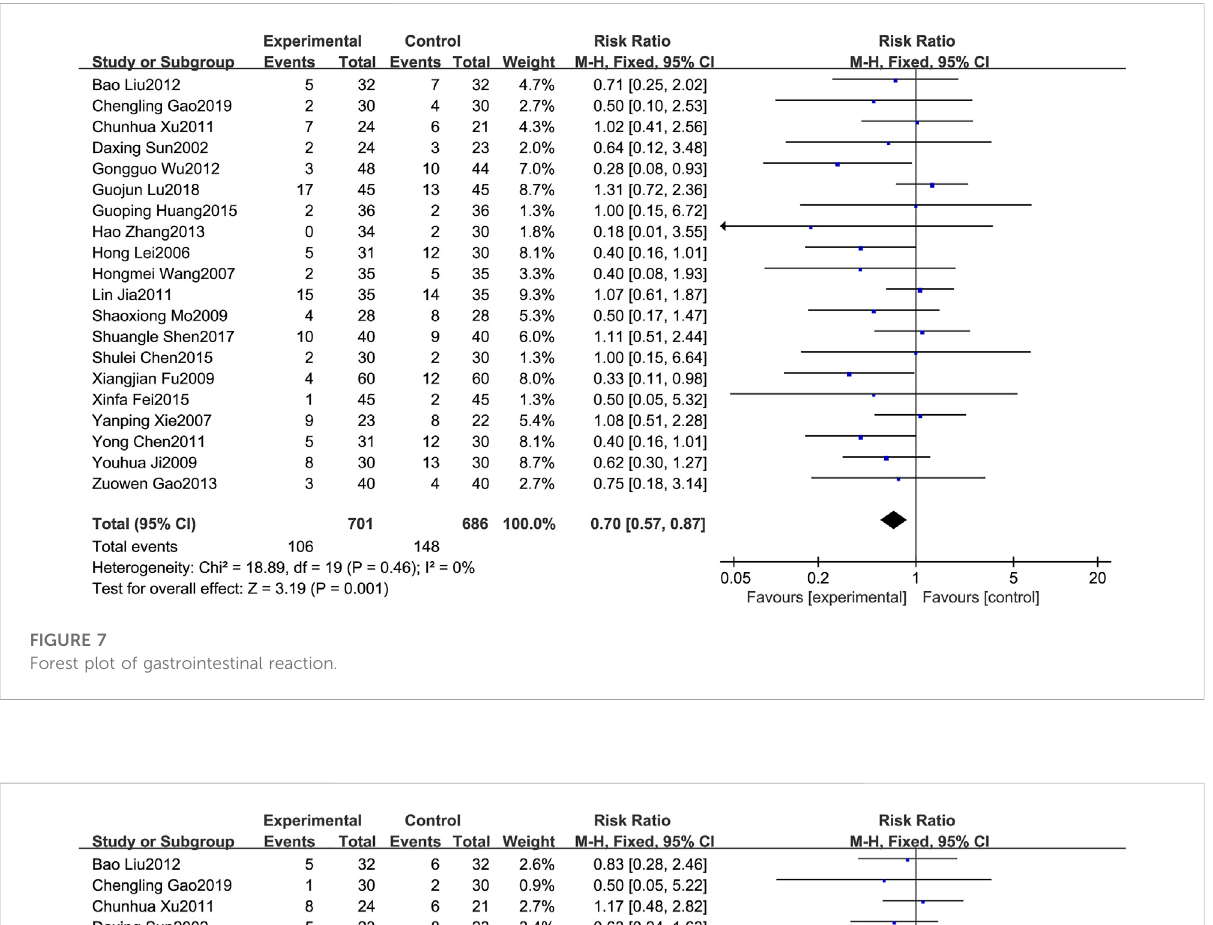
FIGURE 7 Forest plot of gastrointestinal reaction.